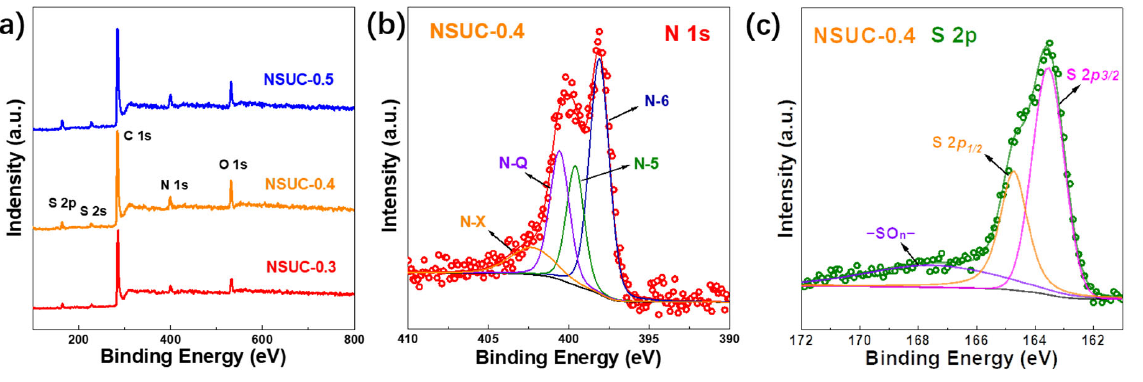
Figure 3. ( a ) XPS spectra of NSUC ‐ x. Fitted high ‐ solution XPS spectra of ( b ) N 1s and ( c ) S 2p for NSUC ‐ 0.4.